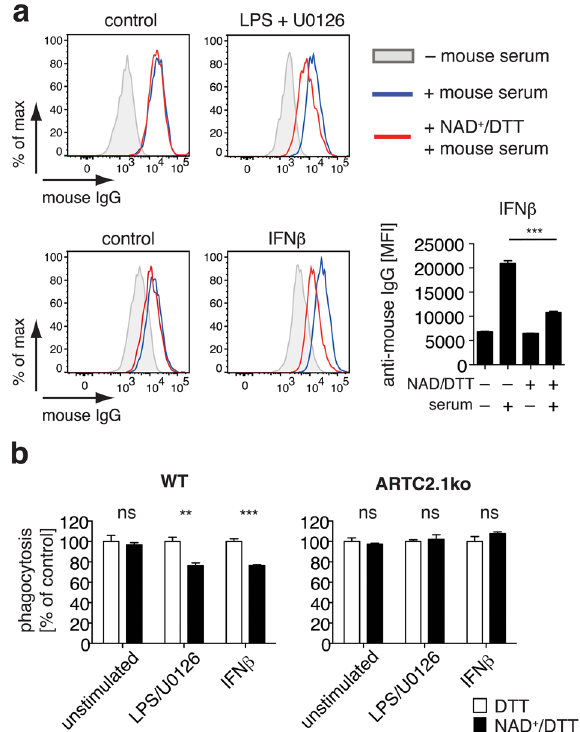
Figure 6. ADP-ribosylation of Fc γ Rs affects binding of IgG to microglia. ( a ) IgG binding to unstimulated, LPS/U0126-stimulated (upper plot) or IFN β -stimulated (lower plot) microglia was analyzed by flow cytometry. Cells were pre-incubated with NAD + /DTT or left untreated, washed twice with PBS and were incubated with IgG containing mouse serum (1:20 diluted) for 30 min. Cells were washed twice and cell surface binding of mouse IgG was measured using a PE-conjugated anti-mouse IgG F(ab) 2 . (b) Phagocytosis of PE-labeled IgG-coated latex beads by unstimulated, LPS-stimulated or IFN β -stimulated microglia from WT or ARTC2.1 − / − mice was measured by flow cytometry. Cells were either preincubated with DTT alone or with NAD + /DTT for 30min, washed twice and allowed to phagocytose IgG-beads for 3h. Phagocytosis rate was normalized to the corresponding DTT control sample (100%). Data are representative of 2–3 independent experiments. Statistical comparison of two groups was performed by using the student’s t test (p < 0.05 = * /p < 0.01 = ** /p < 0.001 = ***